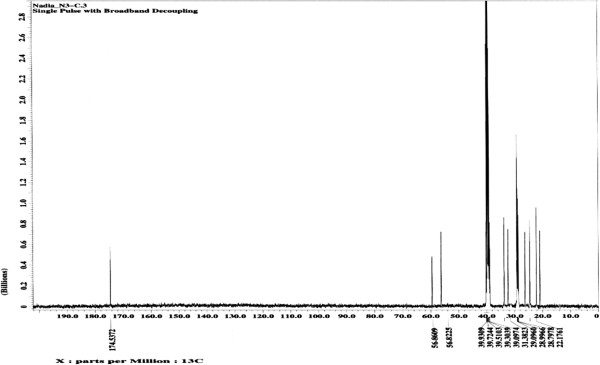
13C NMR spectrum for epoxidized ricinoleic acid (ERA) (2).